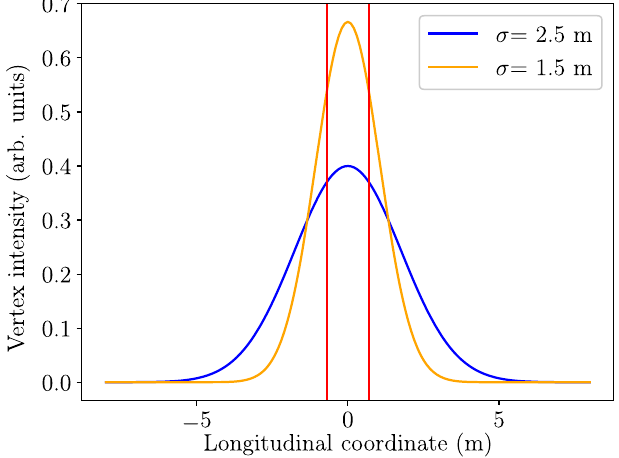
FIG. 2. The longitudinal vertex distribution for a long bunch ( σ s ¼ 2 . 5 m) with the lower frequency cavities (9 MHz) and a short bunch ( σ s ¼ 1 . 5 m) with the higher frequency cavities (28 MHz). The red vertical lines indicate the vertex cut range of (cid:3) 0 . 7 m about the detector center. This cut reduces the instanta- neous luminosity by ∼ 70% and ∼ 50% for long and short bunches,